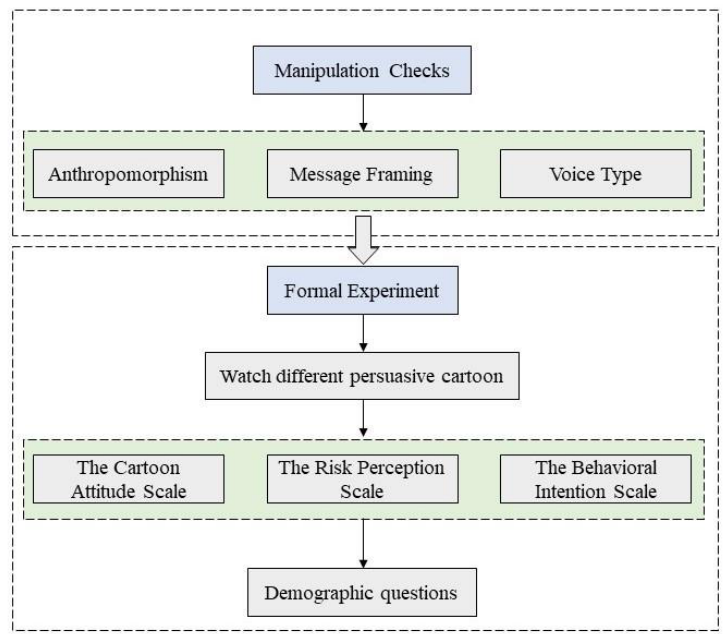
Figure 1. The research procedure framework.